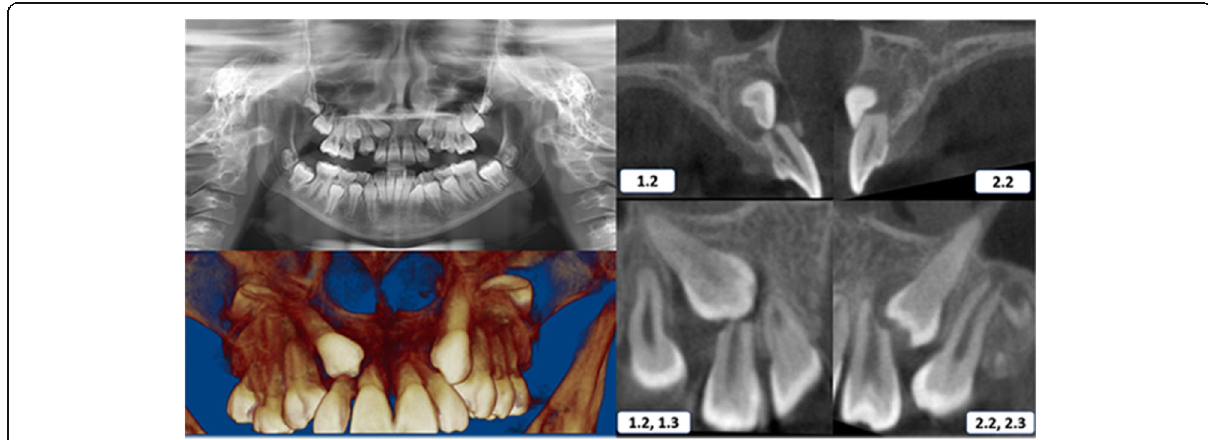
Fig. 3 Initial panoramic radiography and CBCT scans — case 3. 1.1, maxillary right central incisor; 1.3, maxillary right canine; 2.1, maxillary left central incisor; 2.3, maxillary left